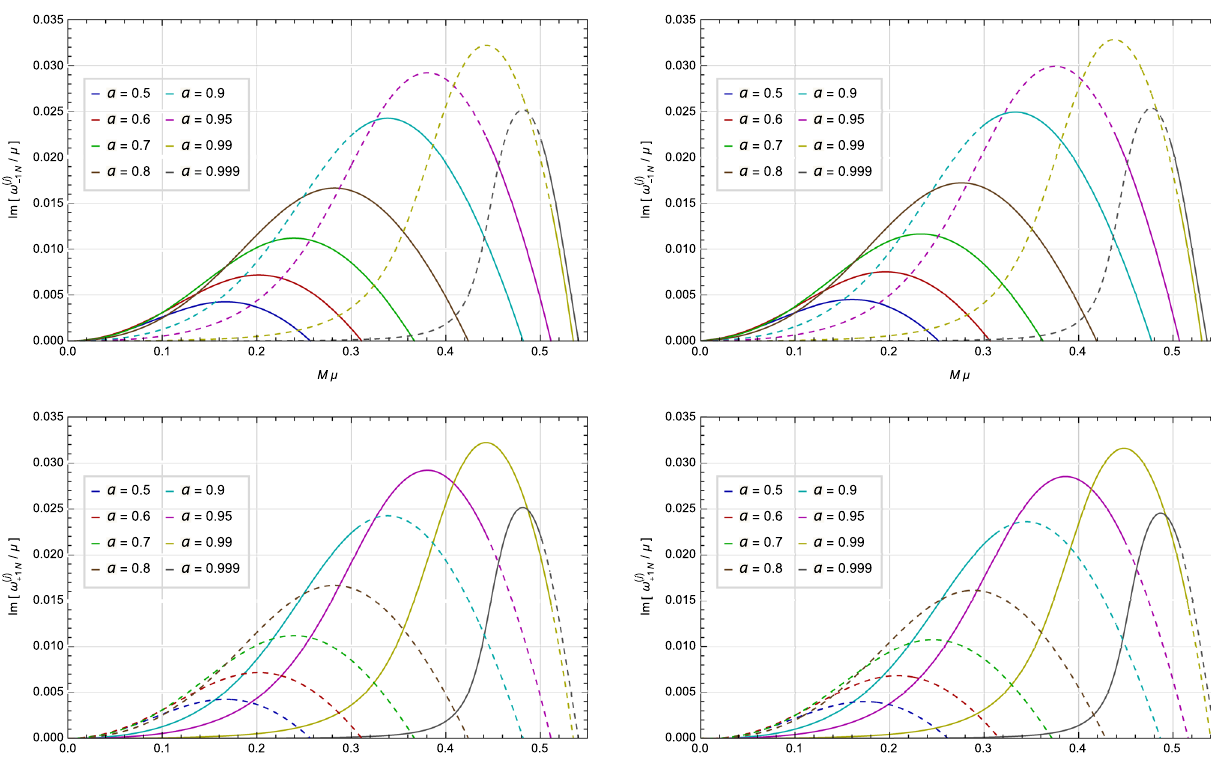
Fig. 4 Instability of the m = − 1 , + 1 states for N = 0. The growth rate of the quasibound states is shown as a function of the gravitational coupling M μ , for a range of black hole rotations a . The left plots show the instability of a Kerr black hole, while the right plots are related to